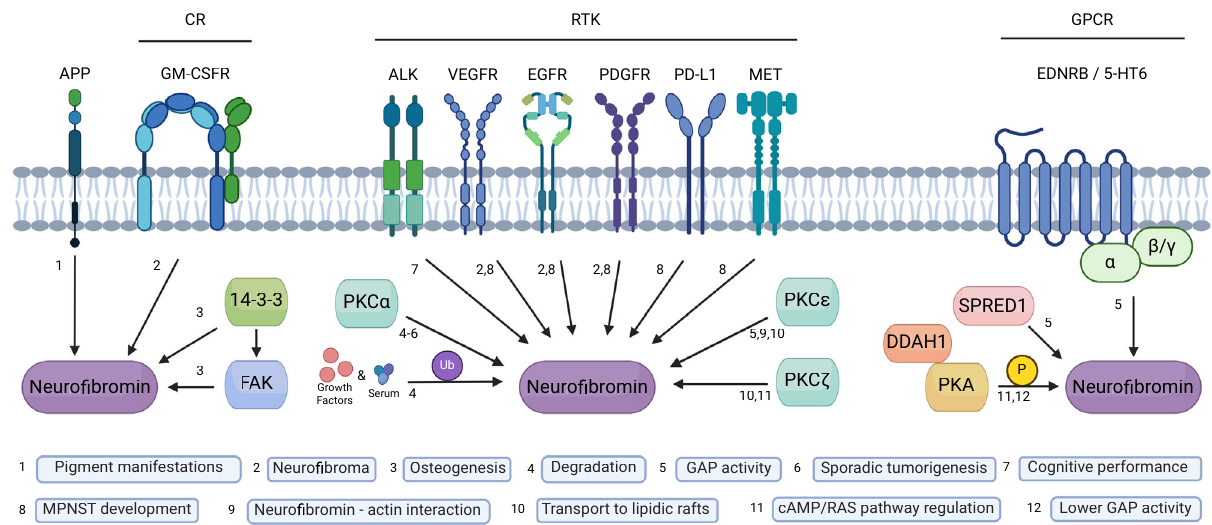
Fig. 2 Signaling proteins upstream of neuro fi bromin. The APP and GM-CSFR, several RTKs and several GPCRs have been involved in neuro fi bromin signaling and with different biological consequences. Main cytosolic upstream regulators of neuro fi bromin include 14-3-3, FAK, PKC, PKA, DDAH1 and Spred1. Neuro fi bromin posttranslational modi fi cations include phosphorylation and ubiquitination.